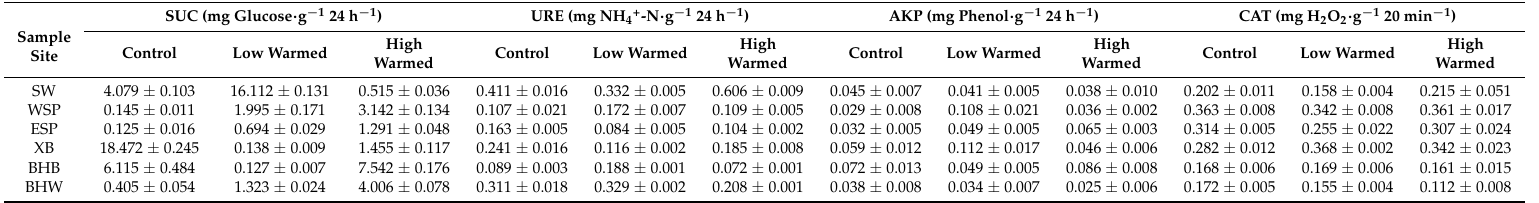
Table 3. Enzyme activity of the six GIWs in different flooding periods after two months of incubation.